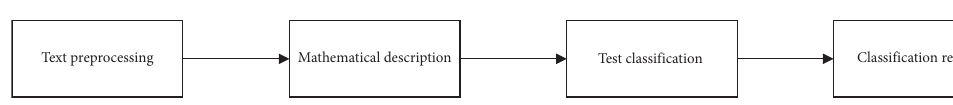
Figure 2: Text classification test